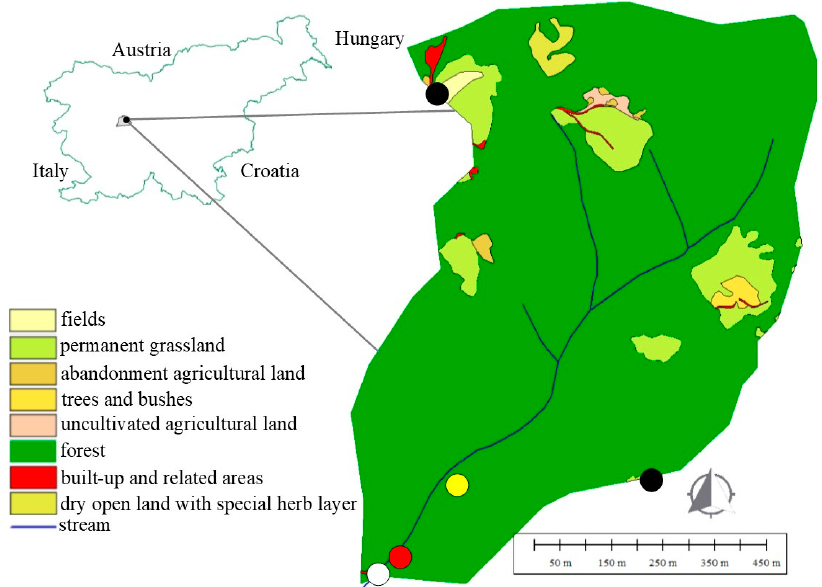
Figure 1. Land use in the Kuzlovec catchment. Black dots represent locations of rain gauges. White, red, and yellow dots represent locations of multiparameter sonde, water level sensor, and soil moisture sensors in three depths, respectively.